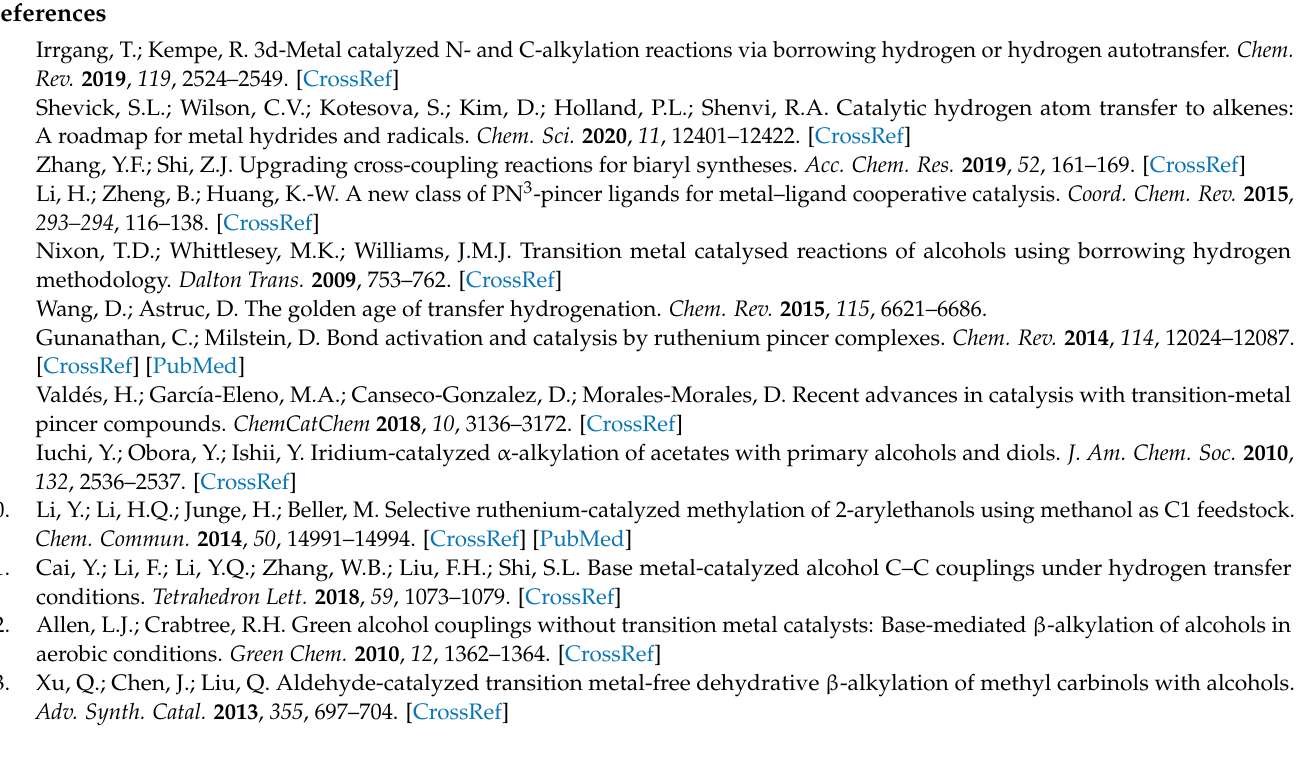
C CP-MAS NMR spectrum. Figure S3: SEM image. Figure S4: TEM image. Figure S5: EDS elemental mapping. Figure S6: FT-IR spectrum. Figure S7: Pore-size distribution. Figure S8: PXRD patterns. Figure S9: XPS survey scan spectrum. Figure S10: XPS spectra. Figures S11 and S12: